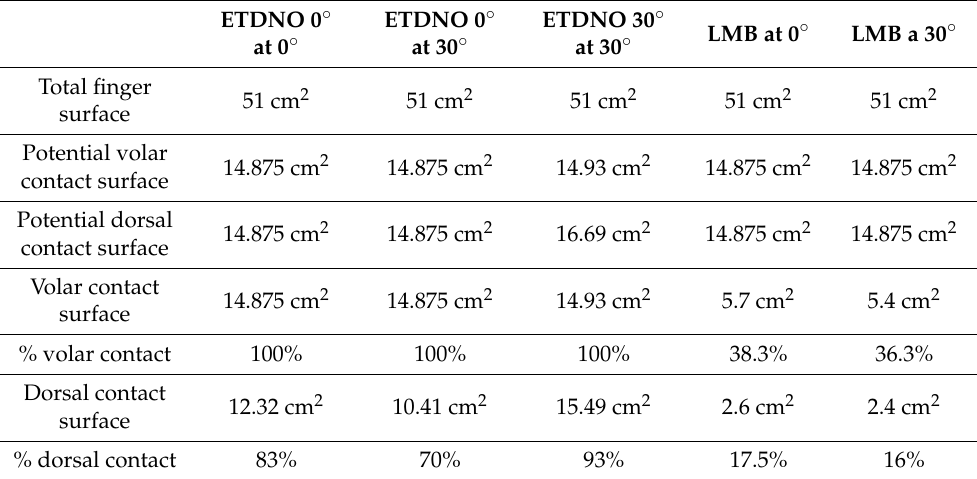
Table 3. Contact pattern of straight tube ETDNO, flexed tube ETDNO and LMB